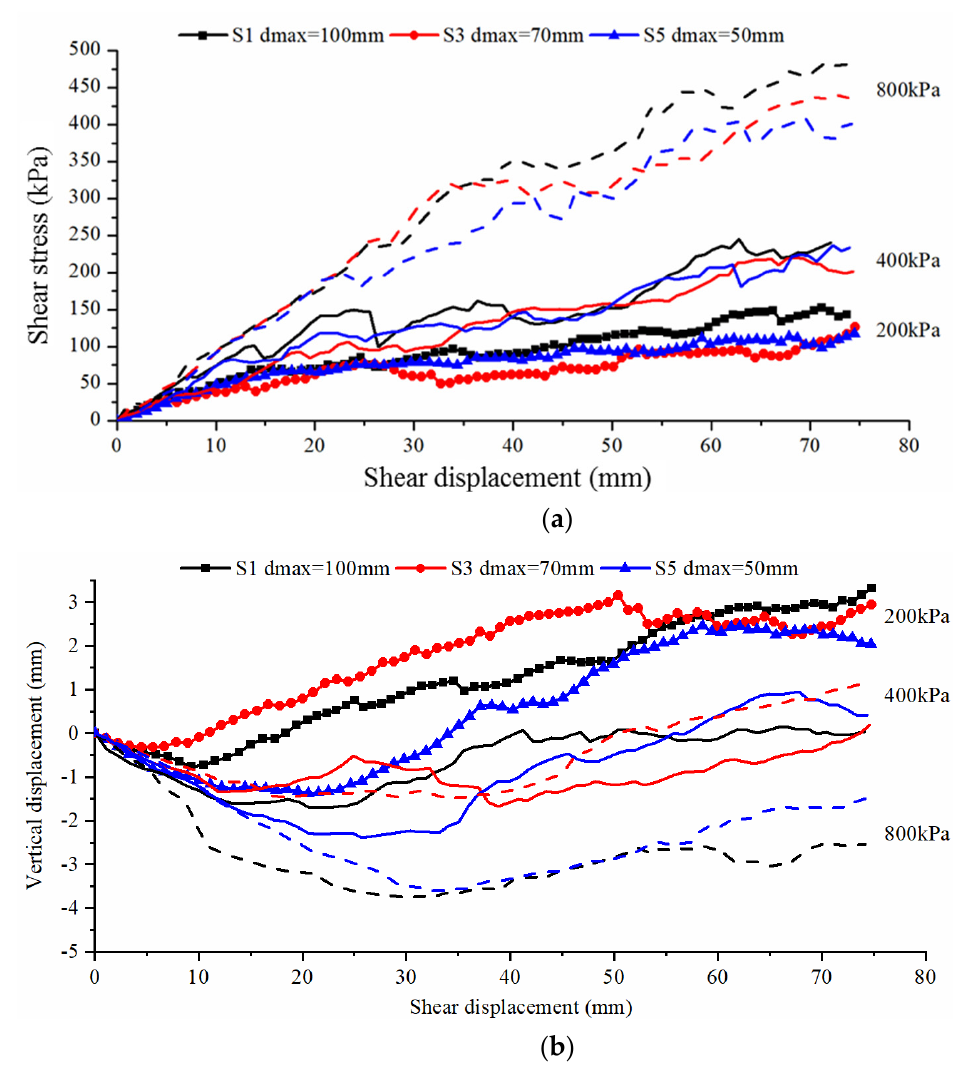
Figure 9. Shear displacements from numerical simulation of SRM samples. ( a ) Relationship between shear stress and shear displacement; ( b ) Relationship between vertical displacement and shear displacement.